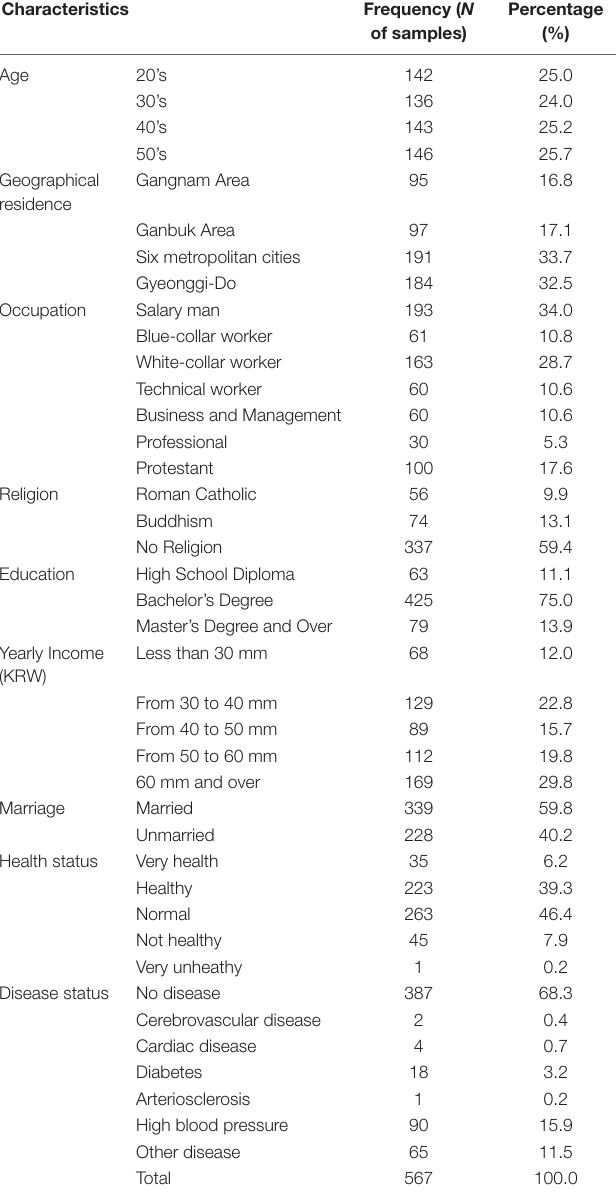
TABLE 3 | Demographic distribution ( N =